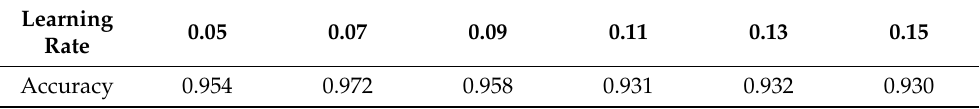
Table 6. The impact of learning rate on performance.